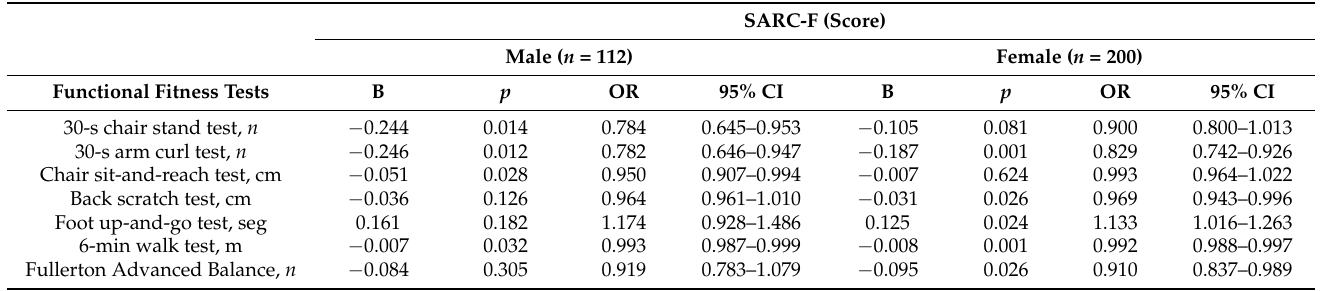
Table 3. Associations through logistic regression between the occurrence of significant symptoms of sarcopenia ( ≥ 4 points) based on the participants’ physical fitness.